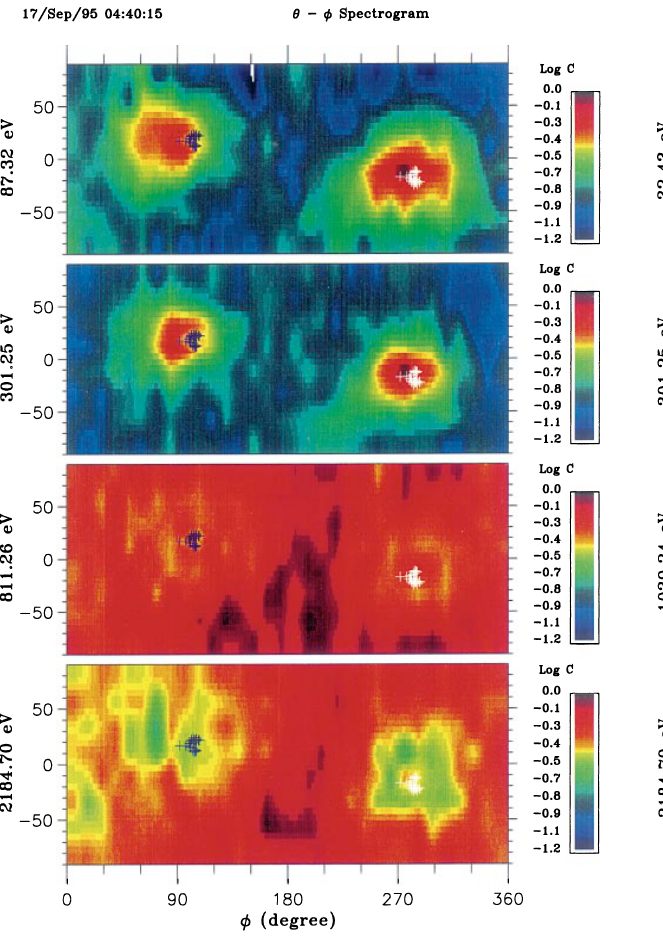
Fig. 7. Same as Fig. 6 but for a region where the LLBL and plasma- sheet plasma are mixed. Note the appearance of a loss-cone at the highest energies